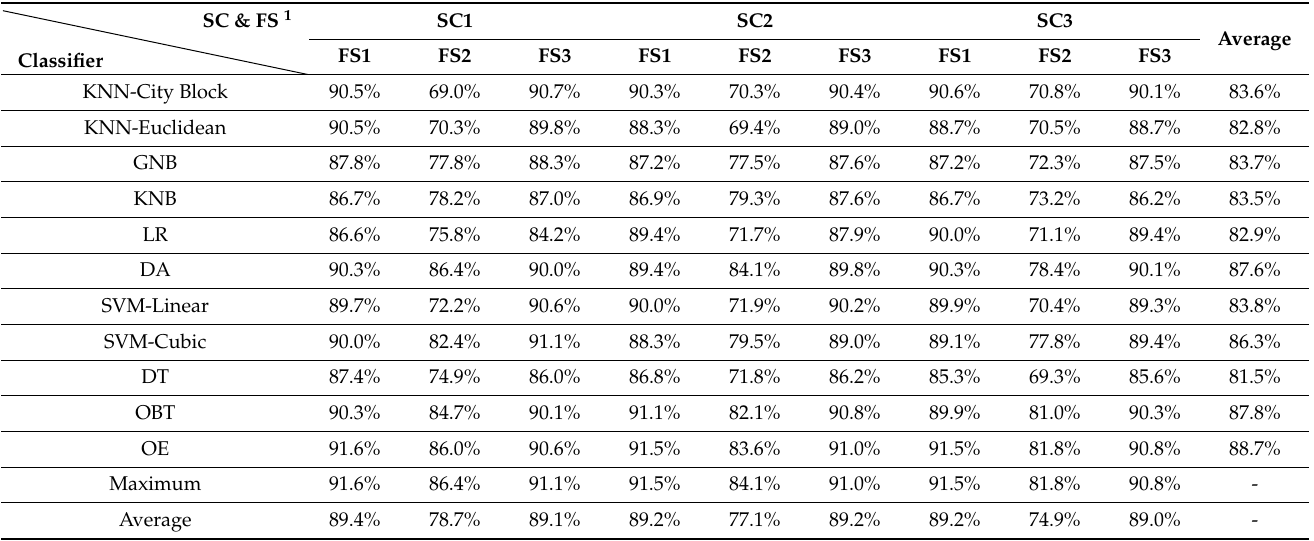
Table 5 (data labeling based on COPV_AP) and Table 6 (data labeling based on PPS). Table 5. Classification accuracies for different sensor configurations and different feature sets using different classifiers (data labeling based on